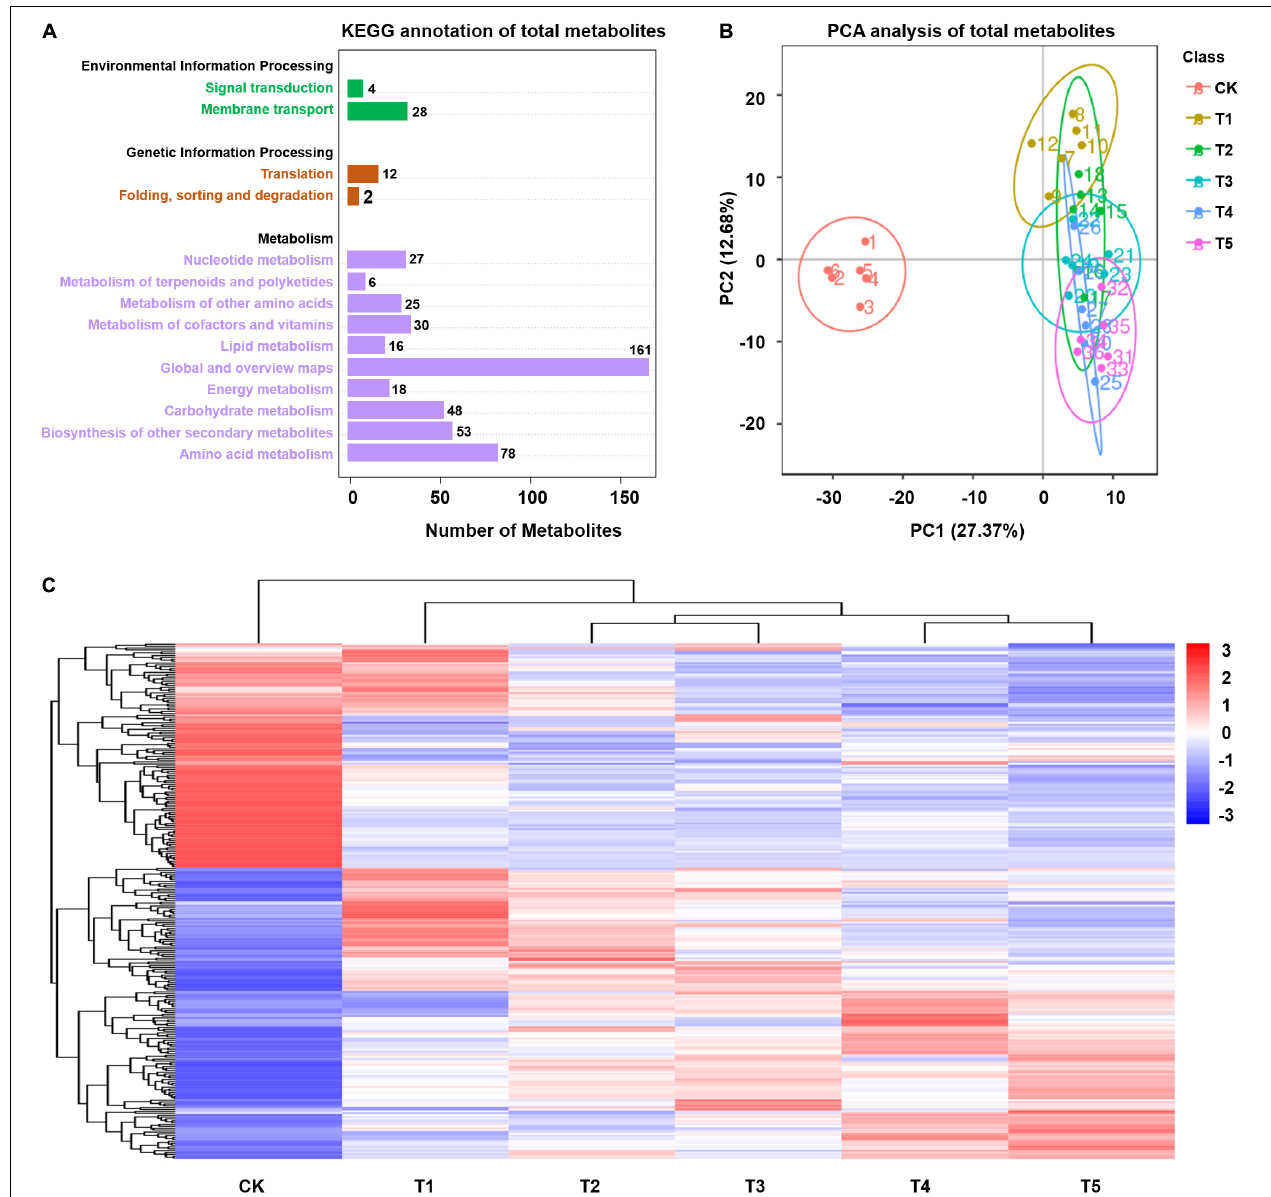
FIGURE 3 | Global metabolome of plants in response to freezing stress. (A) KEGG classification of total metabolites annotated. Numbers above each bar represent metabolite numbers. (B) Principal component analysis (PCA) displays the divergence of the respective metabolomes in response to freezing stress and the control. (C) Differentially expressed metabolites (DEMs) were hierarchically clustered (Euclidean distance) based on their abundance under freezing stress relative to control